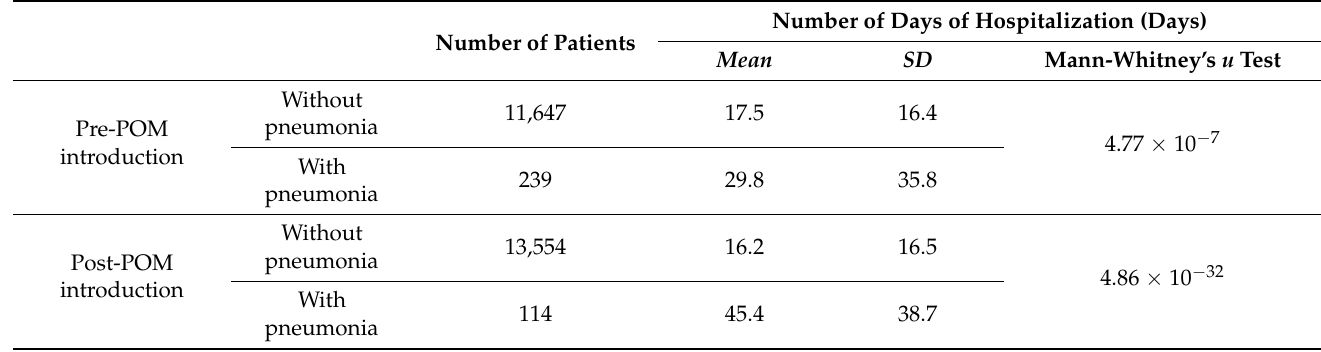
Table 2. Relationship between the number of days of hospitalization and the presence of postoperative pneumonia.